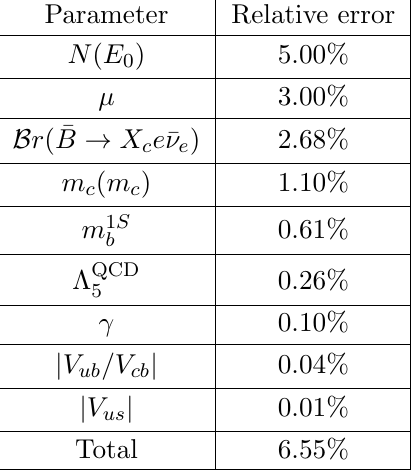
Table 7 . Error budget for the observable B r ( (cid:22) B ! X s (cid:13) ). Here N ( E 0 ) determines the uncertainty arising from non-perturbative